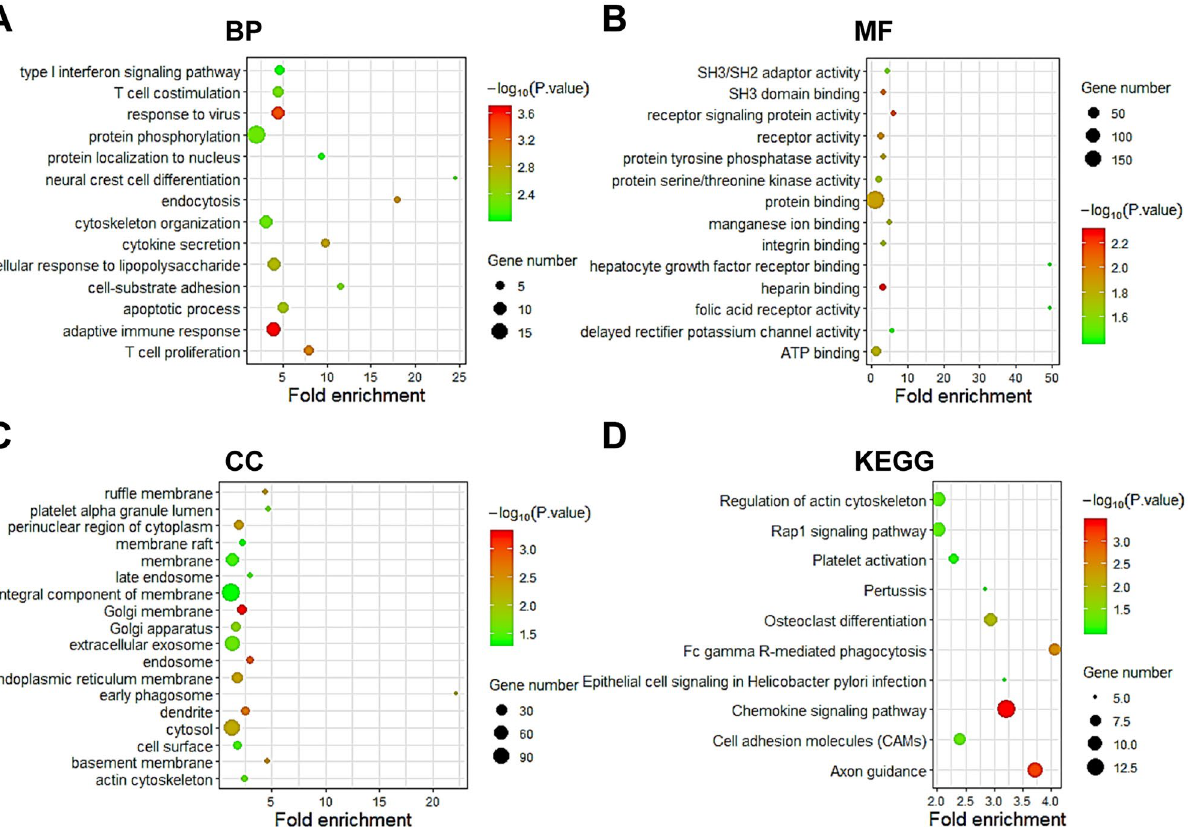
Figure 6. GO and KEGG enrichment analysis of SCAMP5 in AML (DAVID database). ( A ) Biological processes (BPs), ( B ) Molecular functions (MFs), ( C ) Cellular components (CCs) and ( D ) KEGG pathway related to the function of